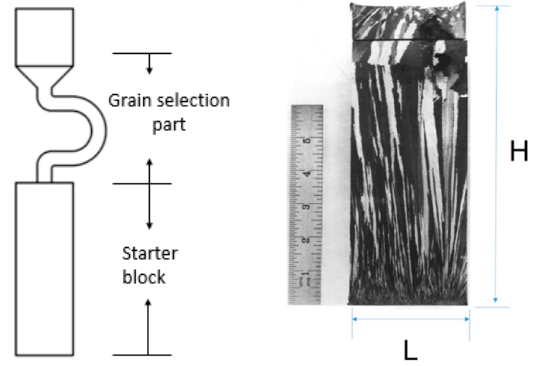
Figure 1. Illustration of the dimensions of the starter block.